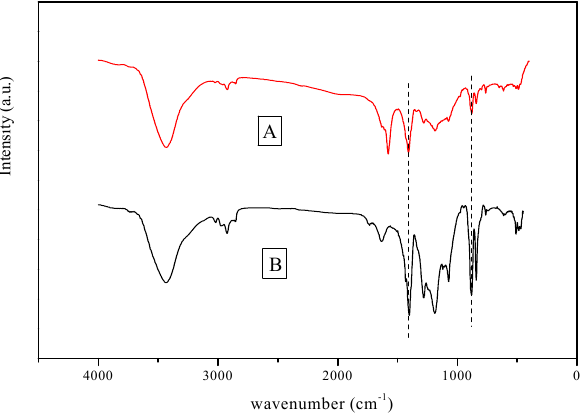
Figure 7. The FTIR image of the membrane. A stands for unmodified PVDF ultrafiltration membrane; B stands for PVDF modified ultrafiltration membrane.